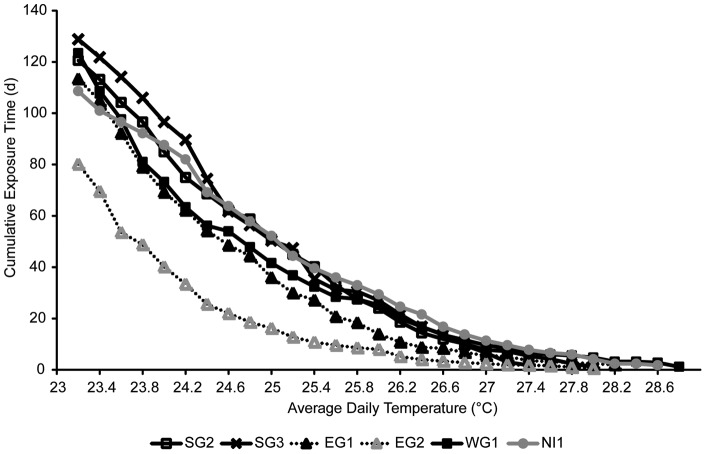
Comparison of estimated bleaching curves among sites at the Abrolhos, illustrating variability in thresholds for site EG2.